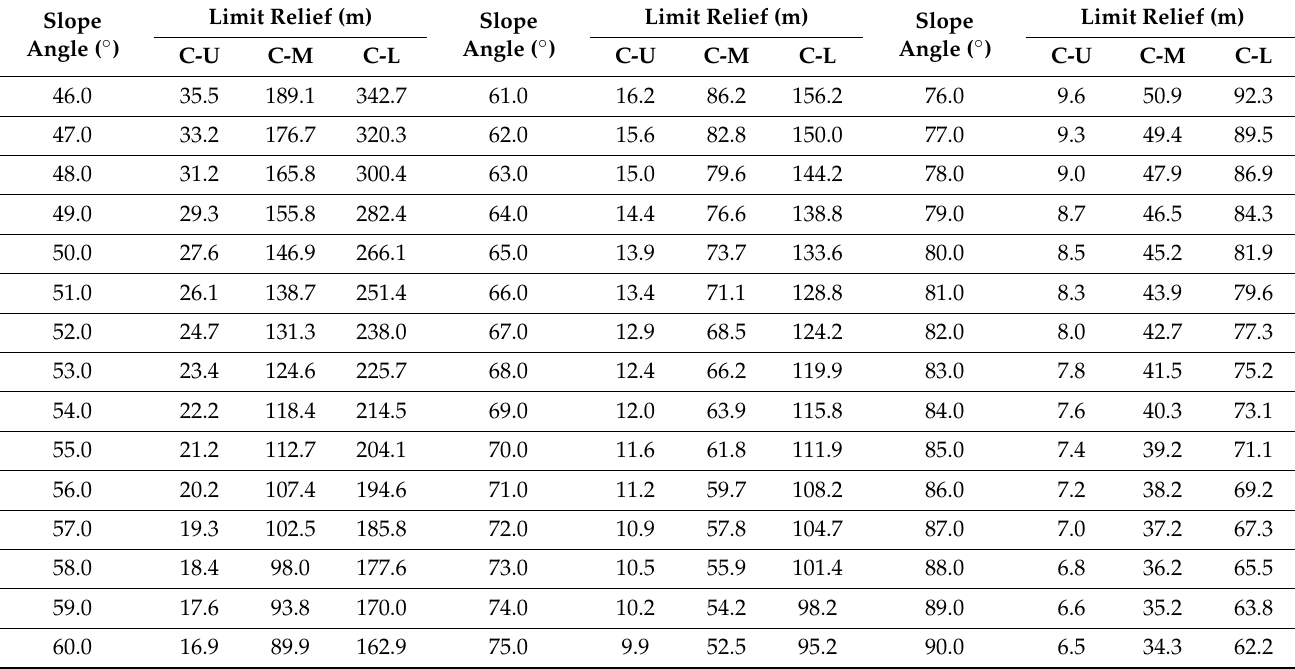
Table 1. Limit relief of the specific areas corresponding to the slope